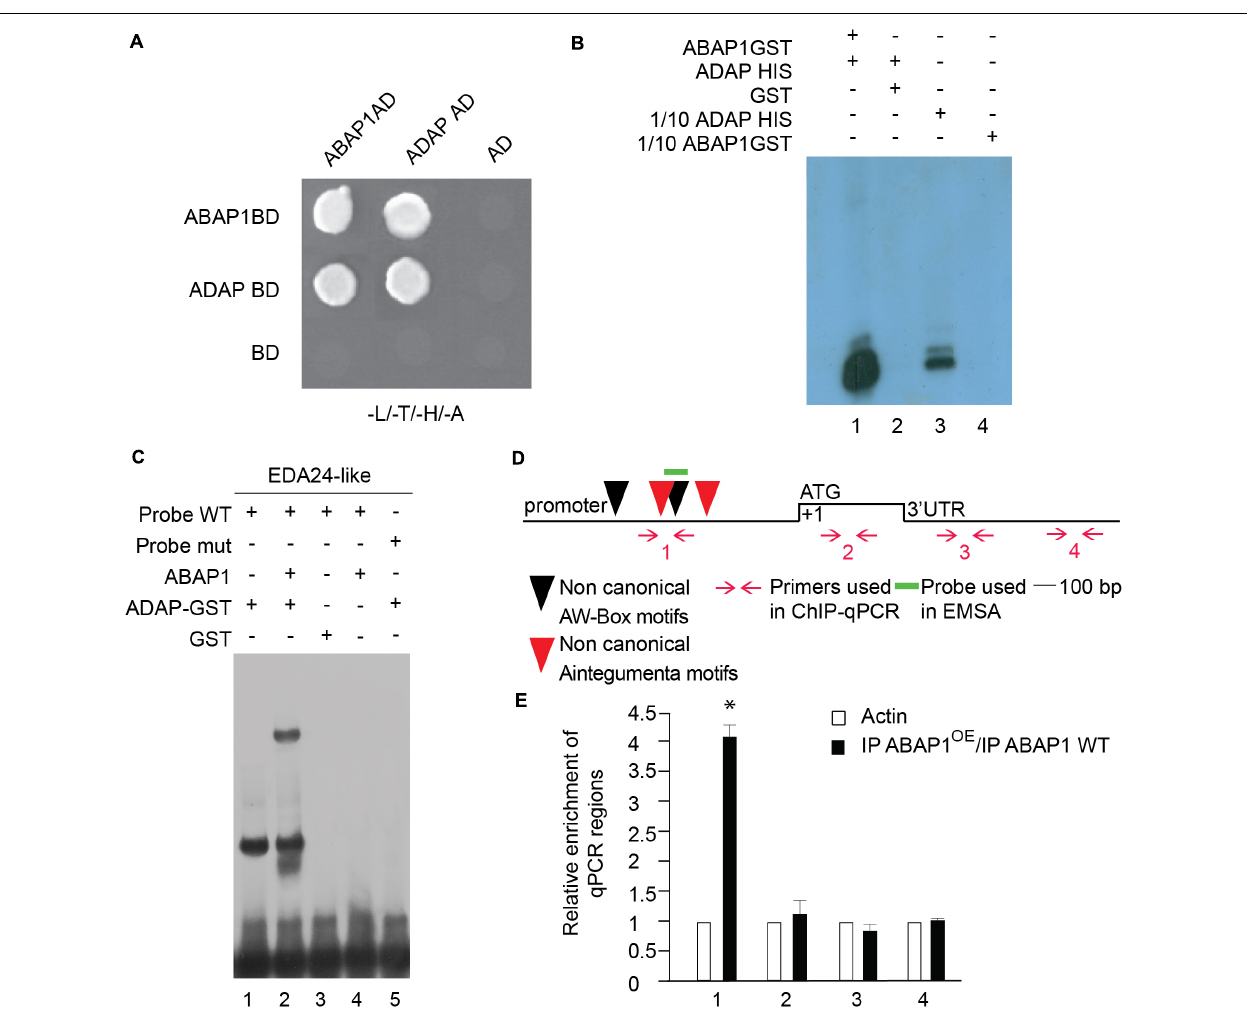
FIGURE 6 | Characterization of ABAP1 and ADAP interaction, and their role in transcription. (A) Yeast two hybrid interaction assays between ABAP1 and ADAP. Negative controls used AD and BD empty vectors. The panel shows conjugated yeasts growing in SD medium lacking leucine, tryptophan, histidine and adenine, for selection of strong protein interactions. (B) GST-pull down assay between ABAP1–GST and ADAP-HIS produced in E. coli . Western blot analysis used anti-HIS antibody. Lane 1, ADAP-HIS with ABAP1-GST; lane 2, ADAP-HIS with GST alone; lanes 3 and 4, 1/10 inputs of ABAP1-GST and ADAP-HIS, respectively. (C) EMSA of ABAP1, ADAP and the complex ABAP1-ADAP with wild-type (WT) and mutated (mut) radiolabeled probes of EDA24-like promoter region harboring ADAP recognition box. Lane 1, ADAP binds to EDA24-like WT probe; lane 2, addition of ABAP1 causes a supershift in the ADAP binding to EDA24-like WT probe; GST alone (lane 3) or ABAP1 alone (lane 4) do not bind to EDA24-like WT probe; lane 5, ADAP does not bind to EDA24-like mutated probe. (D,E) Chromatin immunoprecipitation of wild-type Col (WT) and ABAP1 OE flower buds with anti-ABAP1 antibody. (D) Schematic representation of the amplified regions of EDA24-like gene. ANT non-canonical motifs (located at positions –682 to –696 bp and –892 to –905 bp) are represented as red arrowheads. AW-box non-canonical motifs (located at positions –828 to –842 bp and –1,151 to –1,166 bp) are represented as black arrowheads. Red arrows and numbers indicate primers used for ChIP-qPCR assays, and short green line indicates DNA probe used for EMSA. The translational start site (ATG) is shown at position +1. (E) Chromatin immunoprecipitated with anti-ABAP1 antibody was analyzed by qPCR using gene-specific primer sets, numbered as indicated in (D) . The graph shows the fold enrichment of qPCR amplified regions at the promoter ( 1 ), coding region ( 2 ) and 3 (cid:48) UTR ( 3,4 ) of EDA24-like . The fold enrichment of each amplified region was calculated as a ratio between IP ABAP1 OE and IP WT of values normalized with values of the ACTIN 2 promoter. Error bars represent the SD of three biological replicates. Asterisk ( ∗ ) indicates significant difference from the enrichment according to Student’s t -test ( p -value < 0.05). IP, immunoprecipitated with anti-ABAP1 antibody.